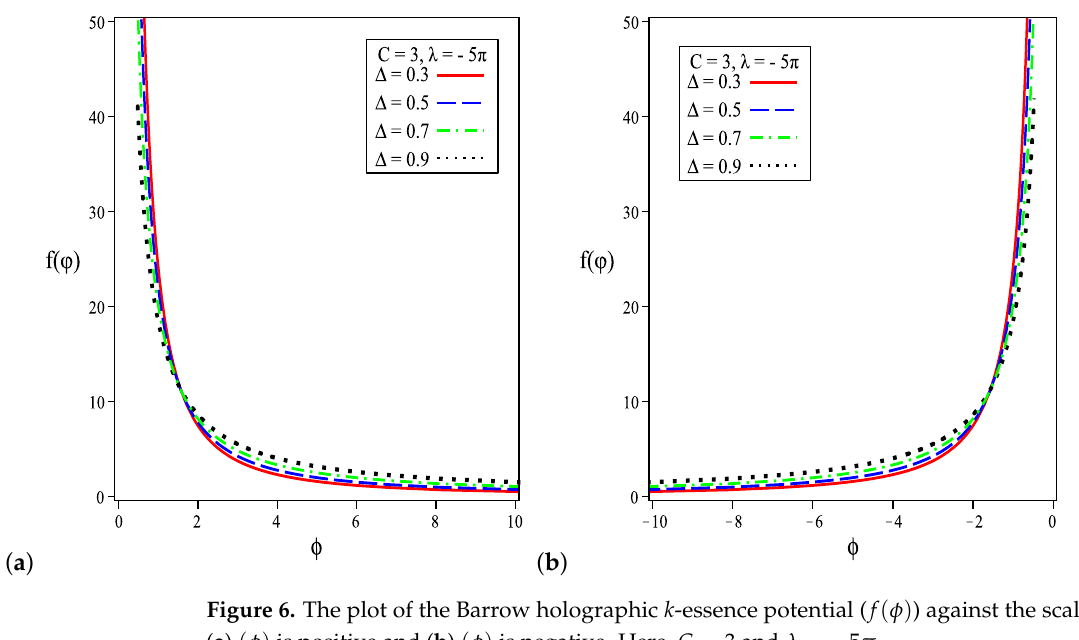
Figure 6. The plot of the Barrow holographic k -essence potential ( f ( φ ) ) against the scalar field ( φ ): ( a ) ( φ ) is positive and ( b ) ( φ ) is negative. Here, C = 3 and λ = − 5 π